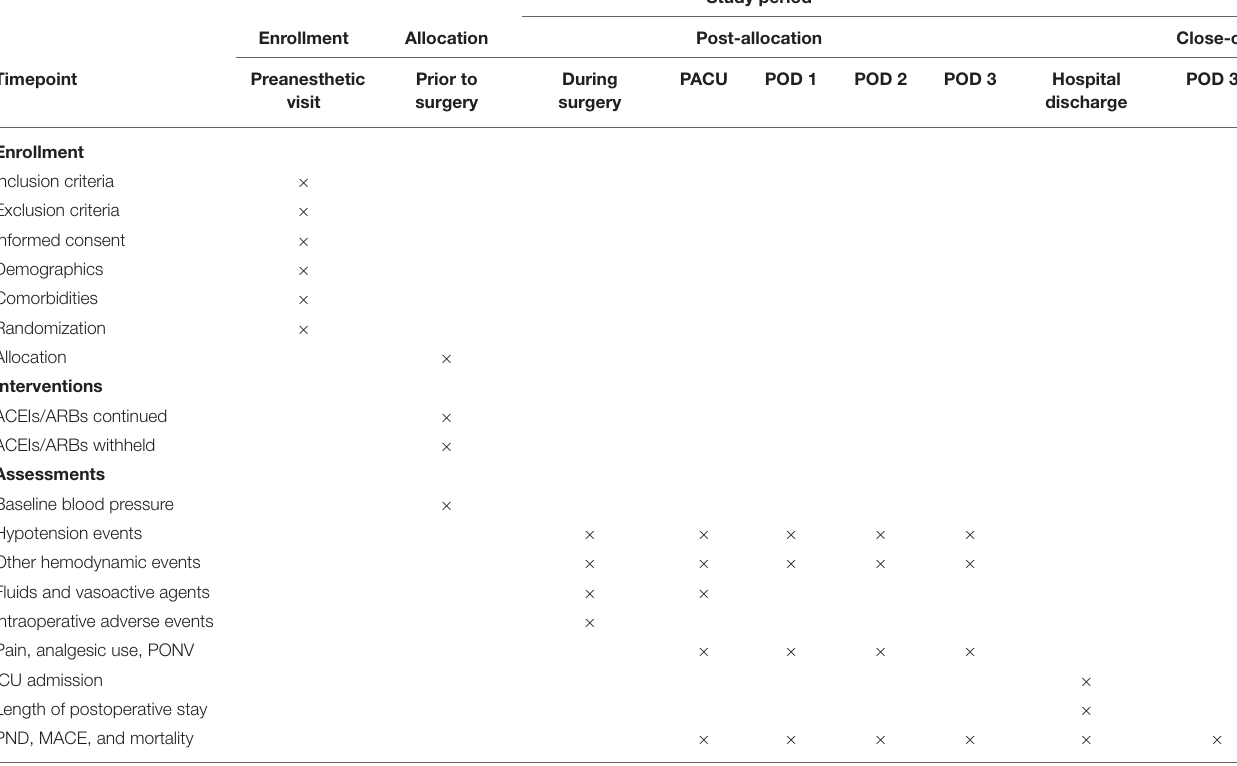
According to SPIRIT 2013 statement of defining standard protocol items for clinical trials. ACEI, angiotensin converting enzyme inhibitor; ARB, angiotensin receptor antagonist; PONV, postoperative nausea and vomiting; PND, neurocognitive disorders; MACE, major adverse cardiocerebral events; POD, postoperative